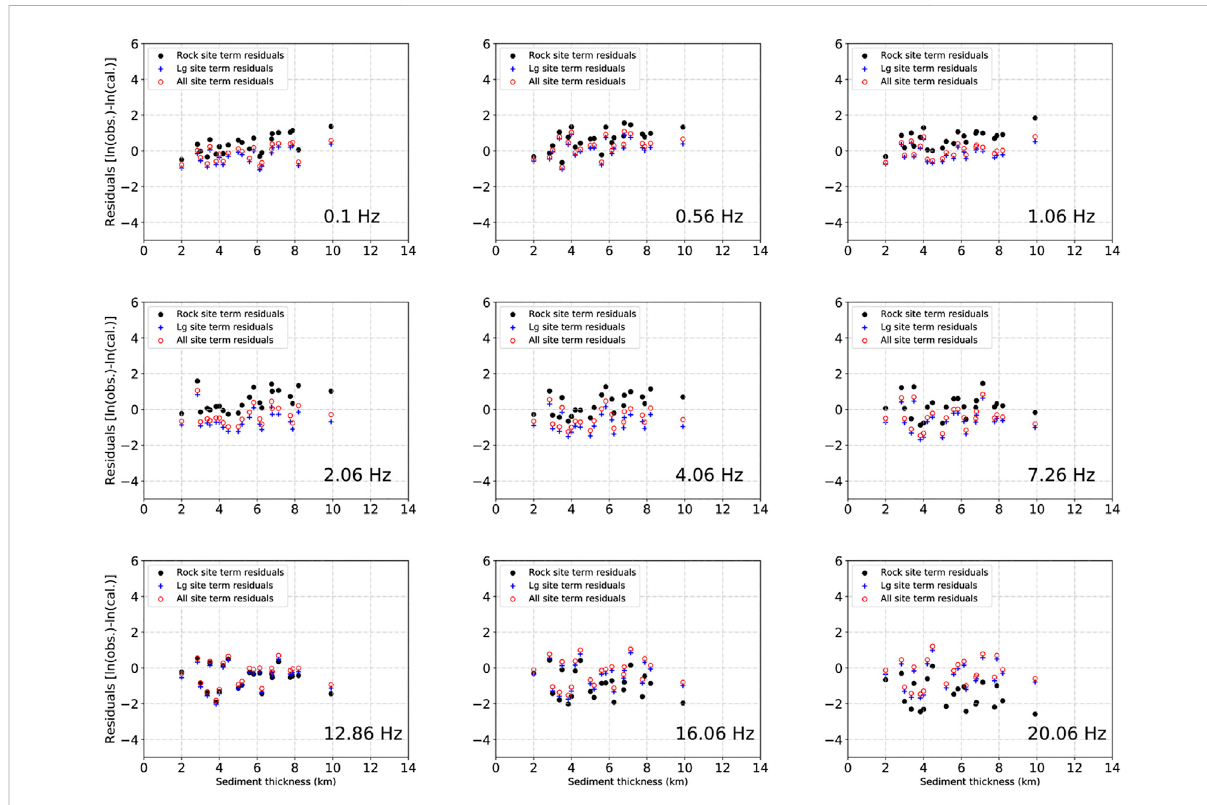
FIGURE 12 Same as Figure 11 but for the 21 October 2020 Ms 4.6 earthquake in central